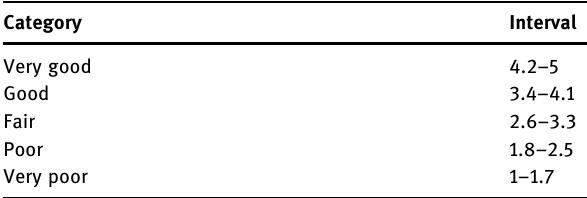
Table 2: Mean value of the respondents ’ answer Category